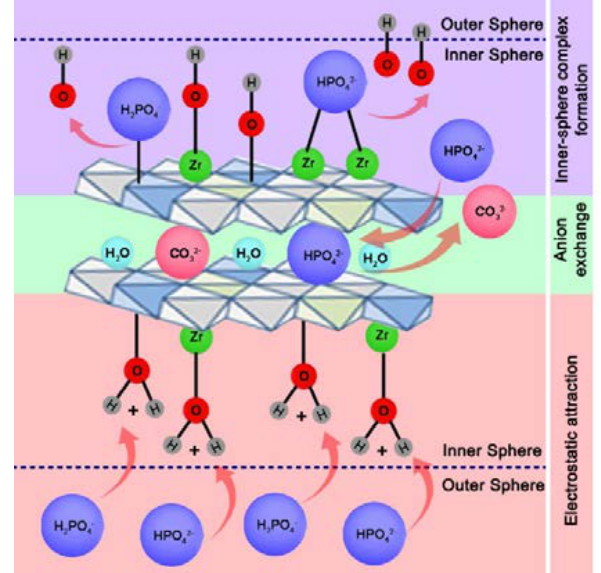
Fig. 9: Proposed mechanism of phosphate adsorption on am-Zr/MgFe-LDH composite